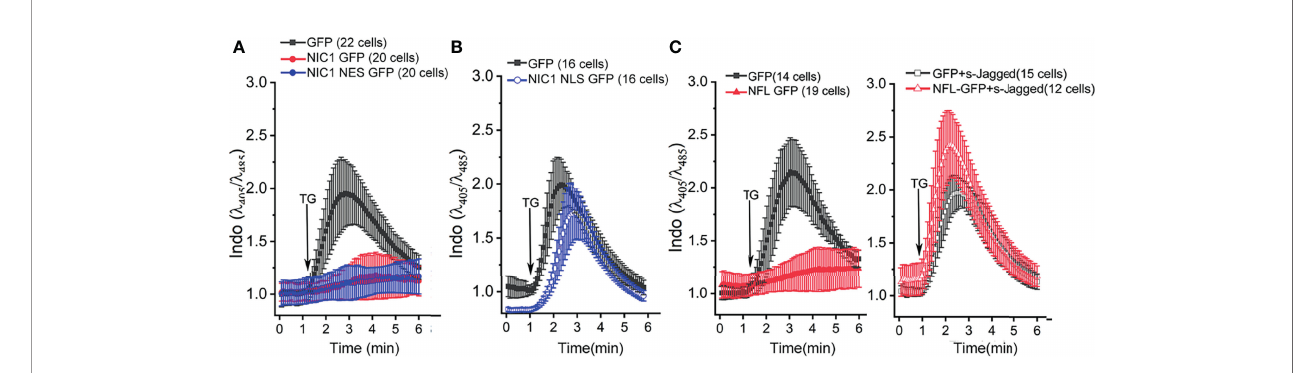
FIGURE 4 | Ligand-dependent, non-nuclear NIC1 signaling regulates ER calcium levels. (A, B) Ratio of intracellular Indo-1 dye fl uorescence at 405 nm and 485 nm at baseline and in response to 2 µM TG in HEK cells measured in calcium-free medium, and imaged 36 h post-transfection with GFP ( ▪ ), NIC1 GFP ( (cid:129) ) or NIC1-NES GFP ( (cid:129) ) (A) or NIC1-NLS GFP ( ⚬ ) (B) . (C) Ratio of intracellular Indo-1 dye fl uorescence at 405 nm and 485 nm wavelength at baseline and in response to 2 µM TG addition in HEK cells measured in calcium-free medium, and imaged 36 h post-transfection with plasmids encoding for GFP ( ▪ ), NFL GFP ( ▴ ), GFP and sJagged ( ▫ ) or NFL GFP and sJagged ( ▵ ). Data plotted as mean ± SD of the total number of cells indicated in parentheses, from three (A) and two (B, C)